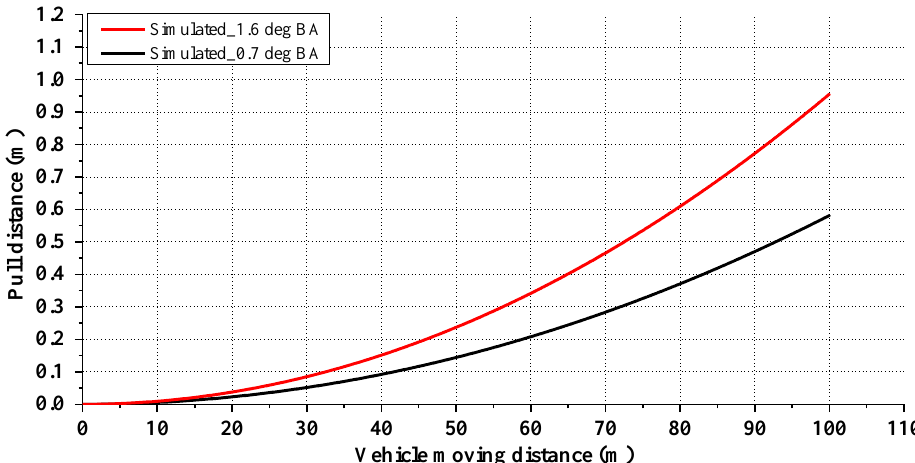
Figure 10. Steering pull estimation results.